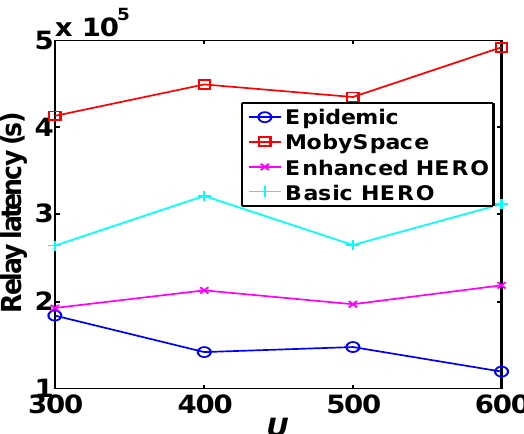
Figure 11. Comparison of relay latency. With the help of home zones, the relay latencies of two HERO algorithms are superior to that of the MobySpace algorithm.